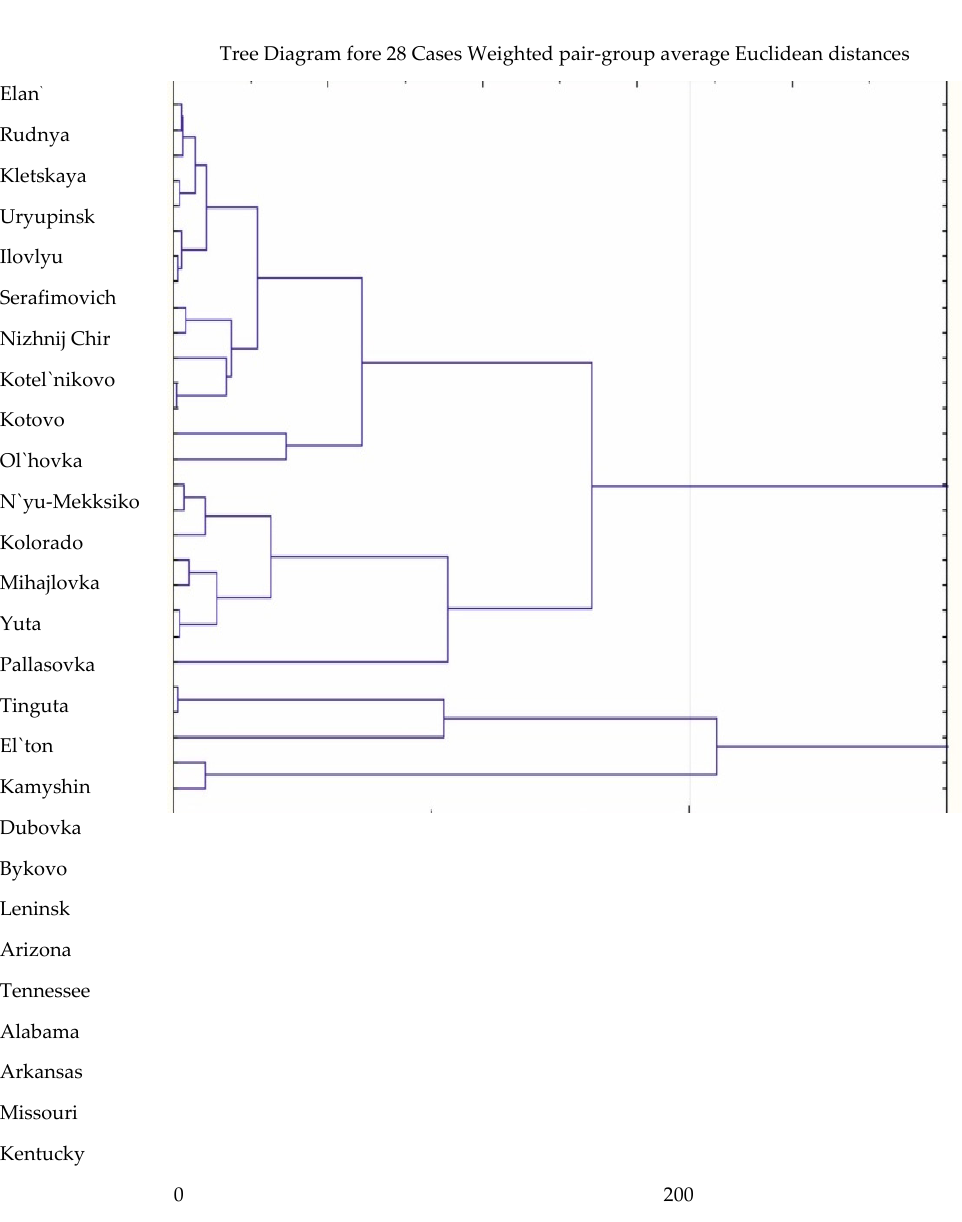
Figure 3. Dendrogram of similarity of climatic indicators of natural and secondary distribution areas of species of the genus Robinia L.